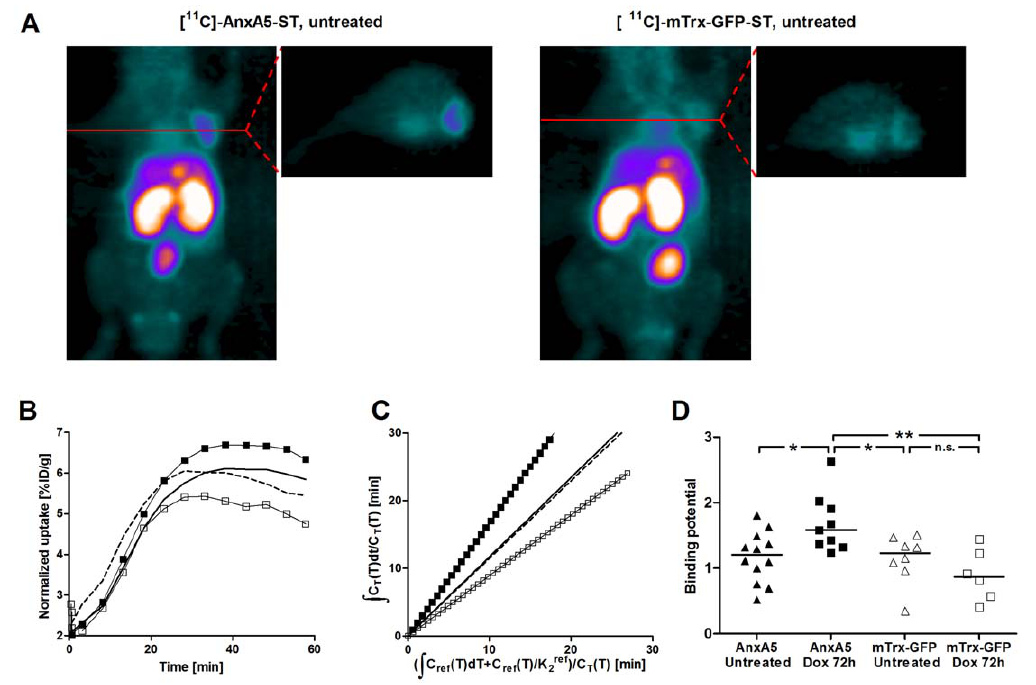
Figure 2. Increased tumor uptake upon doxorubicin treatment using [ 11 C]-AnxA5-ST but not [ 11 C]-mTrx-GFP-ST. A ) MIP and transaxial images of radioactivity (summed over 10–55 min) after tail vein injection of [ 11 C]-AnxA5-ST (left) or [ 11 C]-mTrx-GFP-ST (right) in a mouse bearing a FaDu xenograft without doxorubicin treatment. B ) Time activity curves for tumor uptake of [ 11 C]-AnxA5-ST (solid squares or solid line) and [ 11 C]-mTrx- GFP (empty squares or dashed line) in untreated mice (lines) or 72 h after a single-dose treatment with doxorubicin (squares). Note the similar